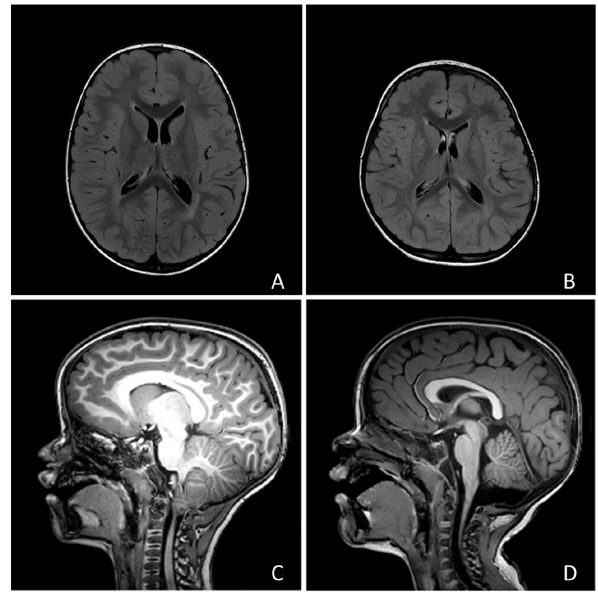
Figure 1. Four examples of the neuroradiological findings we reported in the text: ( A ) Macrocephaly and hyperintensity of peritrigonal white matter; ( B ) Mild asymmetry of lateral ventricles; ( C ) Chiari type I malformation; ( D ) Slight enlargement of Cisterna Magna.